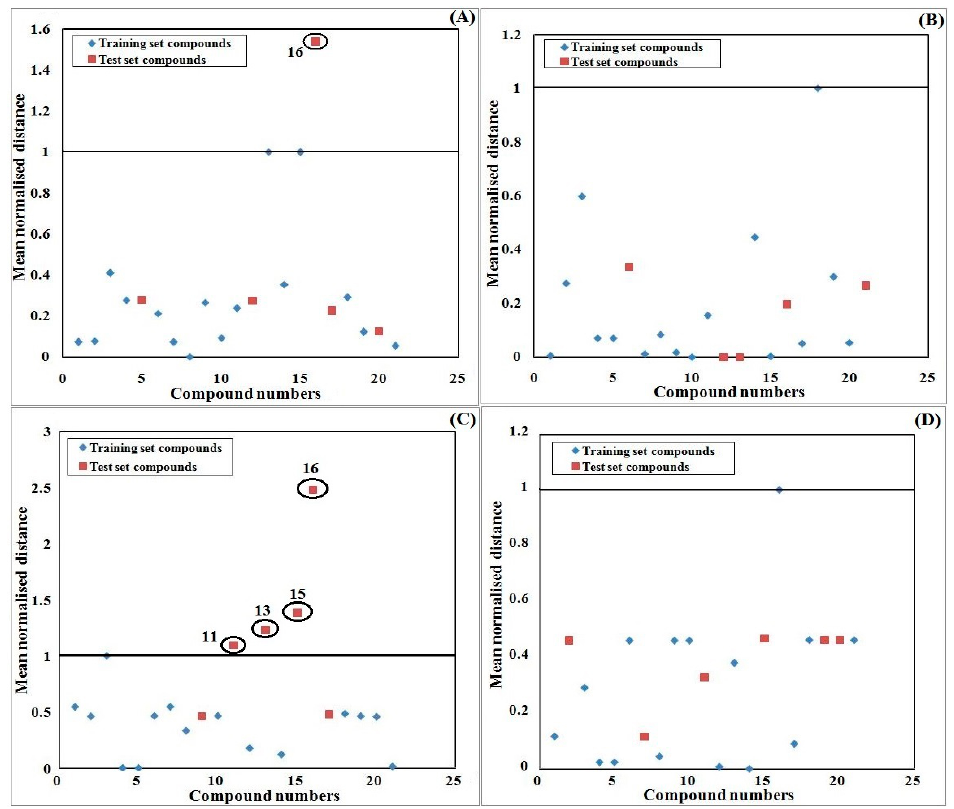
Figure 4. Euclidean distance plots of the developed QSPR model for the AD study. Models were developed with the following dataset splitting methods: ( A ) Activity sorted; ( B ) Euclidean distance based; ( C ) Kennard–Stone based; and ( D ) K-Medoid clustering.